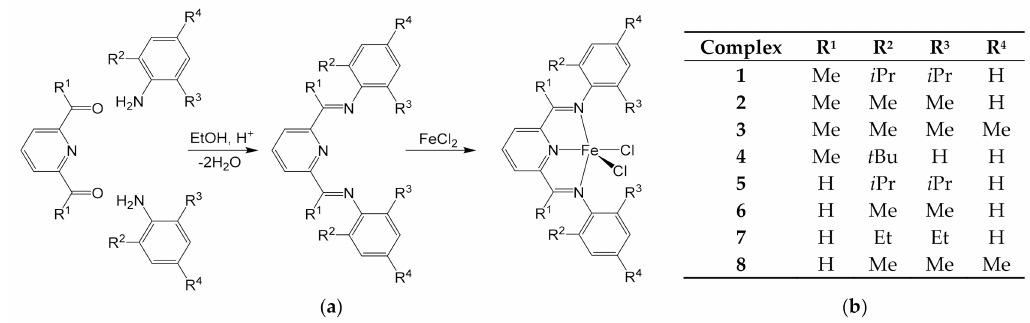
Figure 2. ( a ) The two-step synthesis of the iron pre-catalysts with bis (arylimino)pyridyl ligands for polymerization of olefins and ( b ) different combinations of R 1 , R 2 , R 3 and R 4 groups tested in complexes 1 – 8 [45].